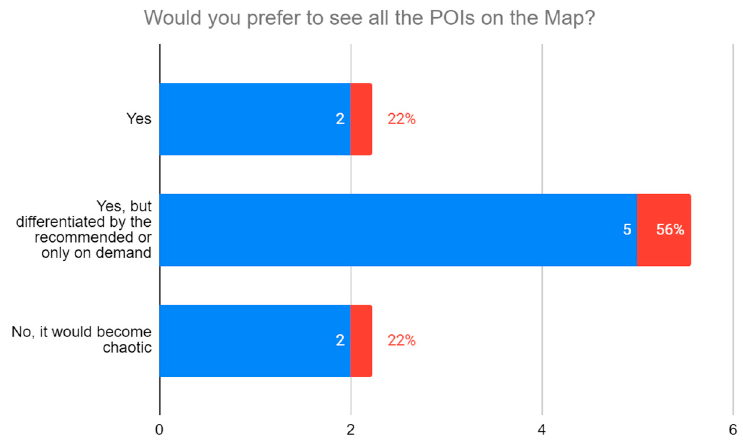
Figure 10. Participant responses on whether they would prefer to be able to see all available POIs on the map (map view) instead of only the recommended ones (personalized map view).